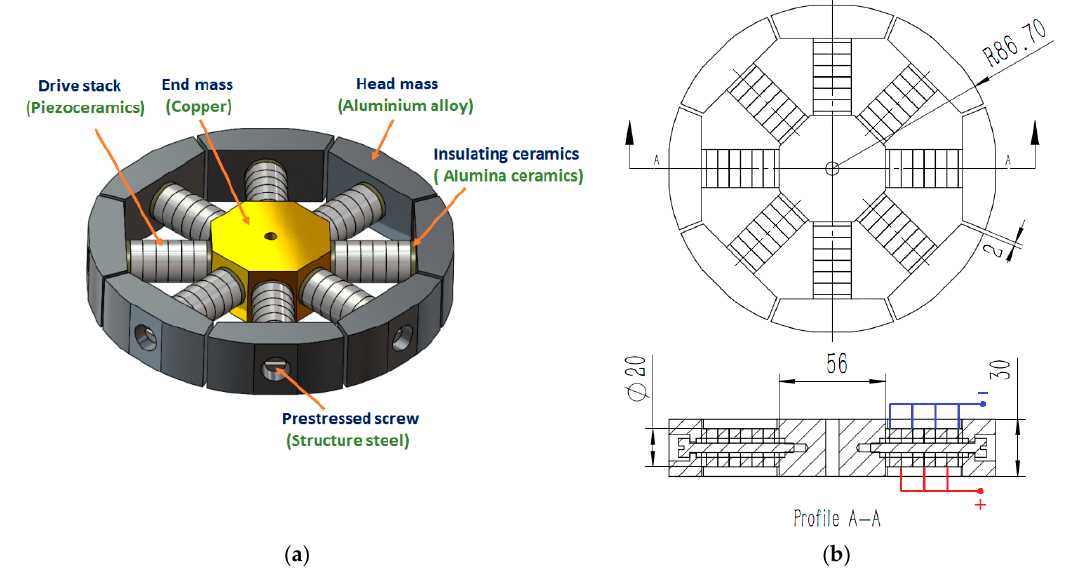
Figure 4. ( a ) The configuration of the spiral sound wave transducer; ( b ) the basic structure size and electrical connection of the transducer, the unit is mm.